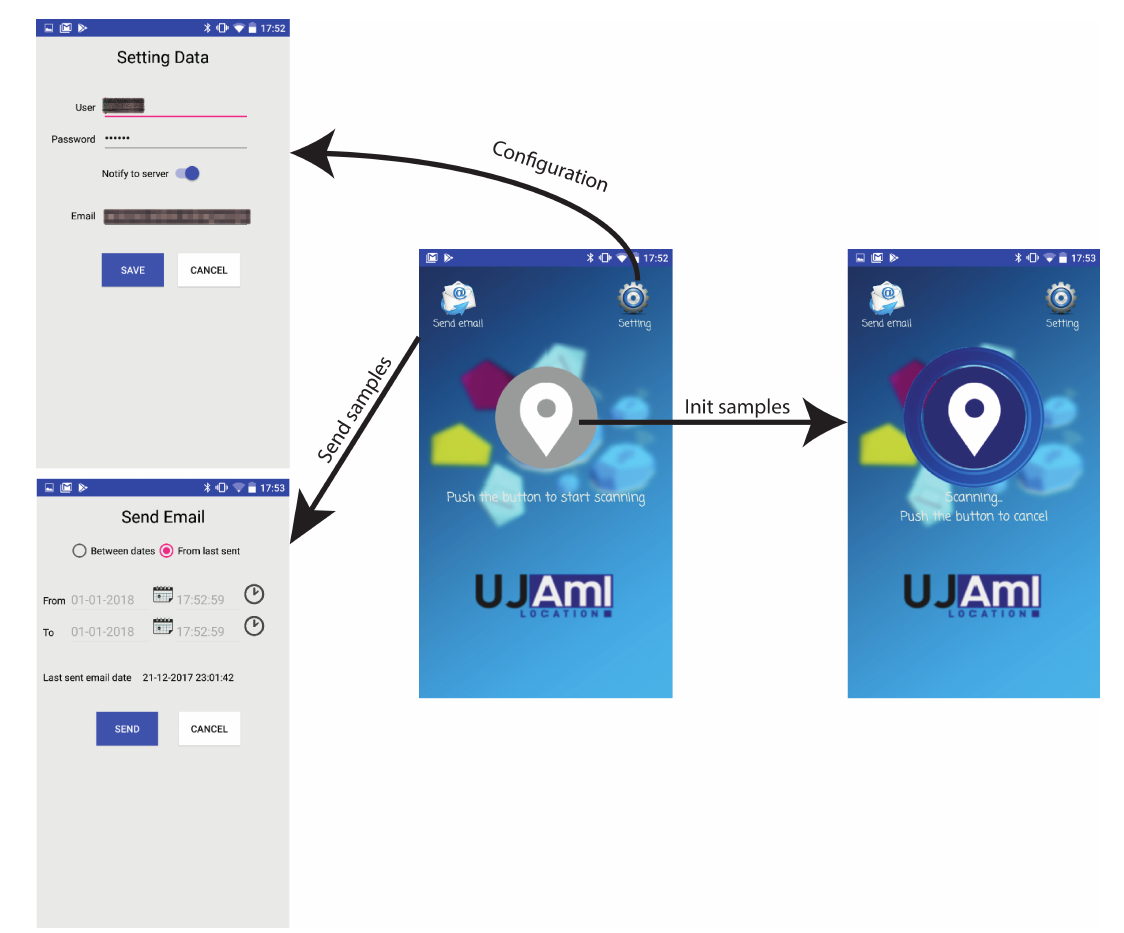
Figure 9. Mobile application